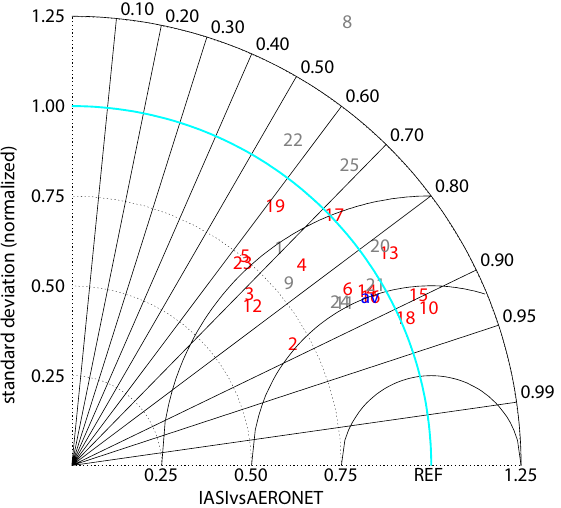
Figure 2. Taylor diagram (normalized) for IASI and AERONET 500nm coarse-mode AOD over oceanic regions. Sites are identified by their number in Table 2. Grey numbers are for “Level 1.5” sites. The overall statistics appear in blue (“av” for average). Correlation shown on the external circle; amplitude: radial distance.